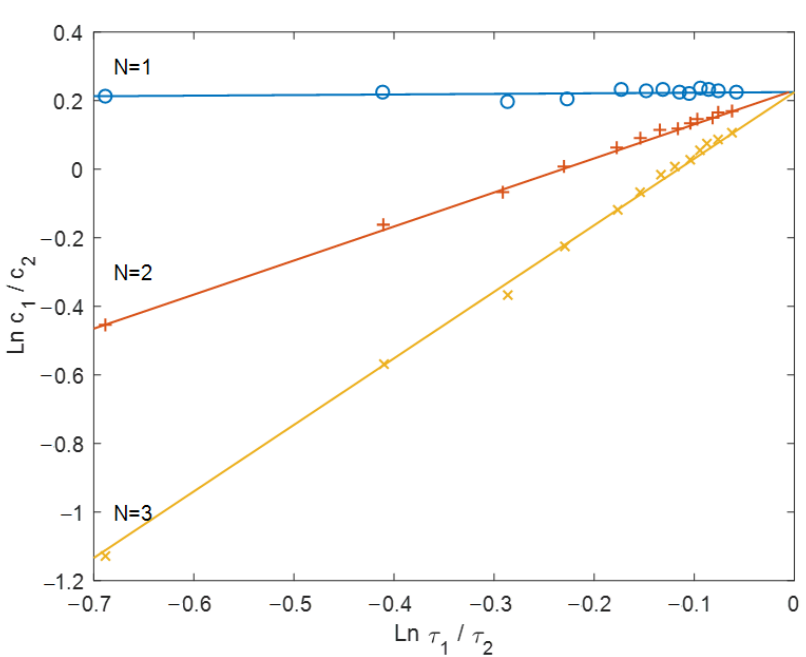
Figure 2. The dependence of lnS c = φ ( lnS τ ) for a cascade of perfect mixing reactors.